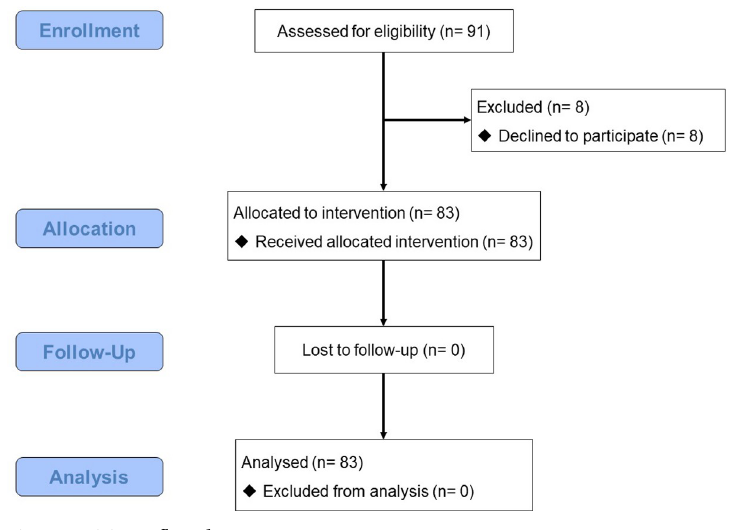
Fig 1. Participant flow